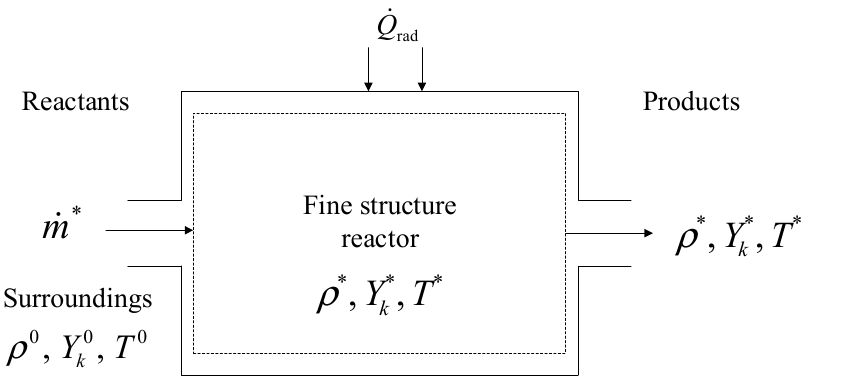
Figure 1. Schematic fine-structure reactor. Reprinted with permission from Ref. [27]. 2022, Elsevier Ltd. The mass inflow rate divided by the mass of the fine structures is denoted by mass balance of the reactor gives a reaction rate for the reactor